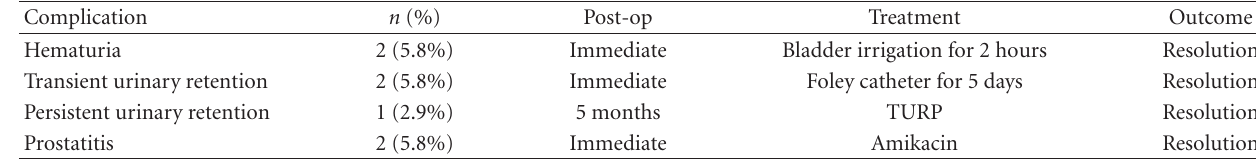
Table 3: Complications after intraprostatic botulinum toxin injection for BPH.